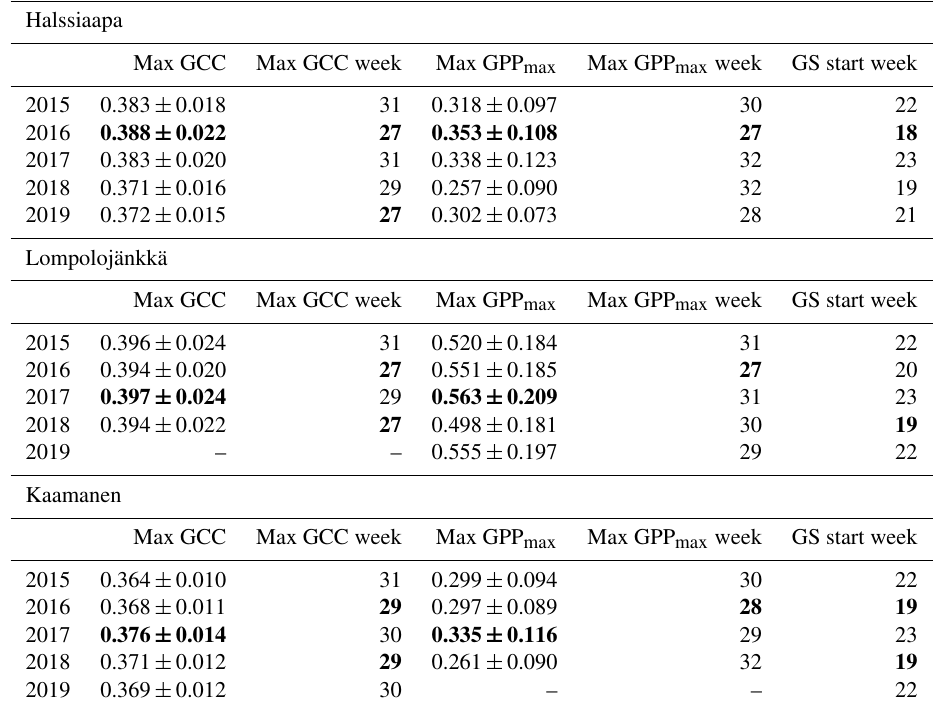
Table 3. The mean GCC and GPP max (mgCO 2 m − 2 s − 1 ) during the week they attained the maximum, the week numbers of these maxima and the week number of the growing season (GS) start. The maximum GCC and GPP max , the earliest maximum GCC and GPP max and the earliest GS start are marked as bold. The maximum GCC data at Lompolojänkkä and maximum GPP max data at Kaamanen are not reported for 2019 due to data